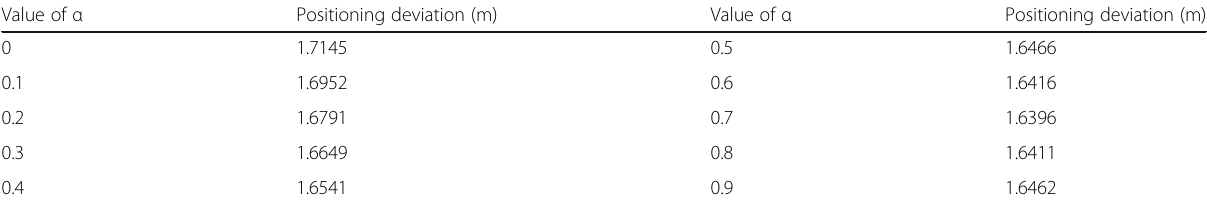
Table 3 The influence of the value of a on the positioning deviation of joint metrics when k = 4 Value of α